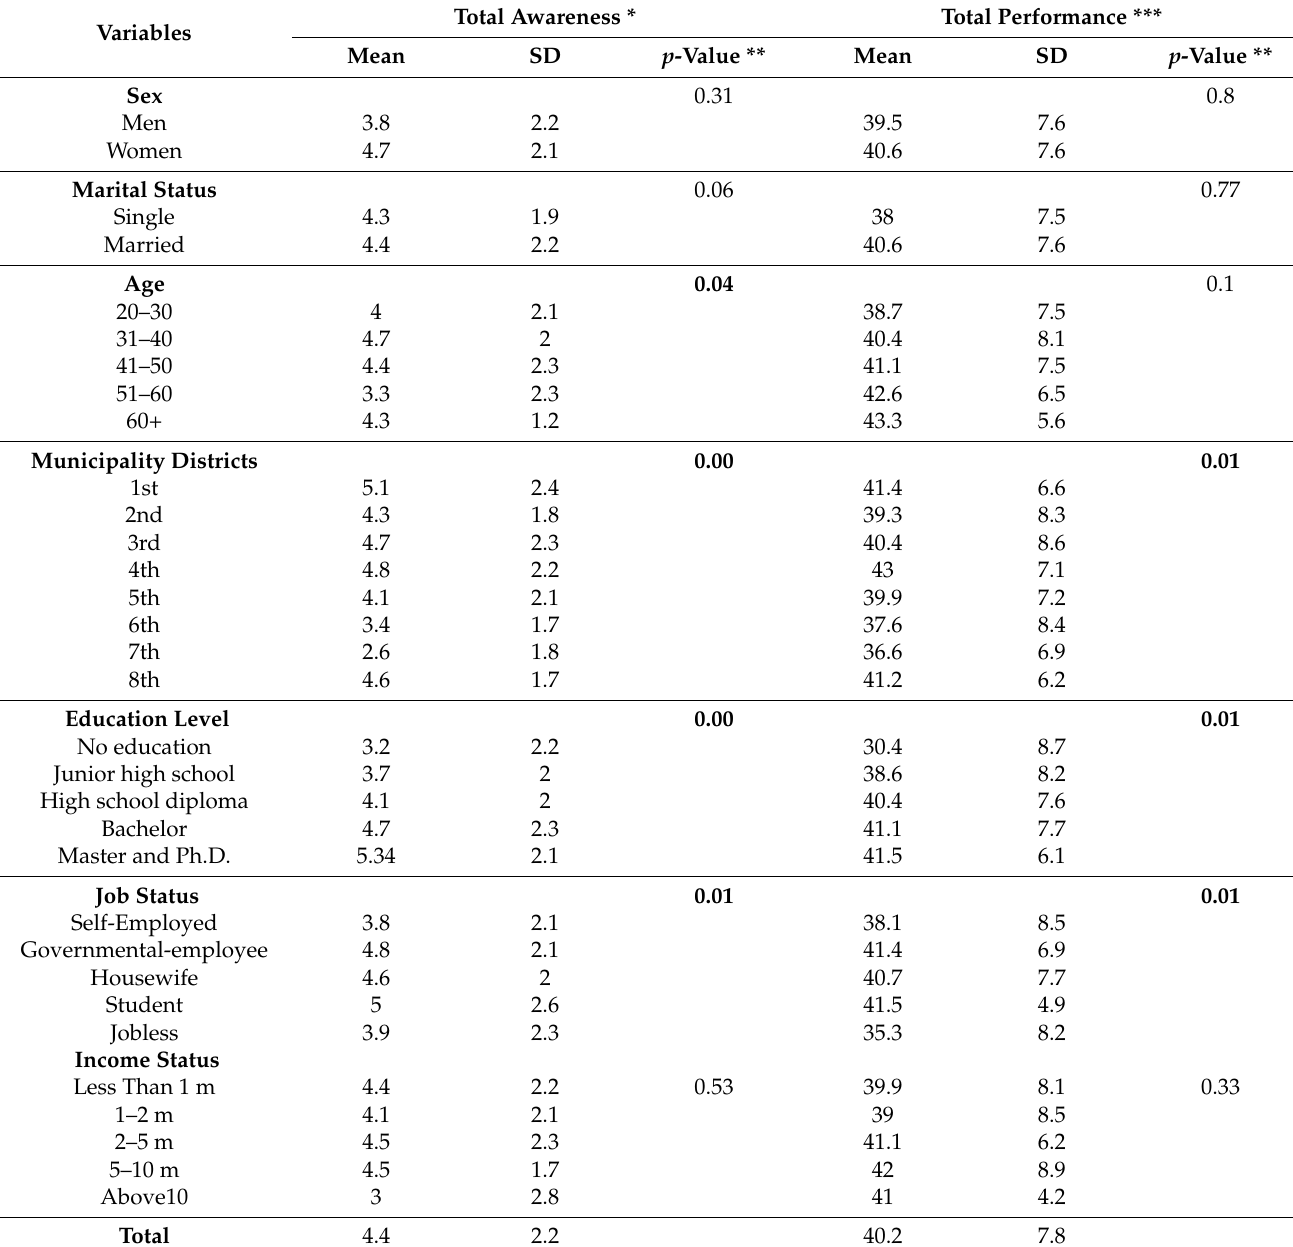
Table 3. Total mean scores of awareness and performance by socio-demographic